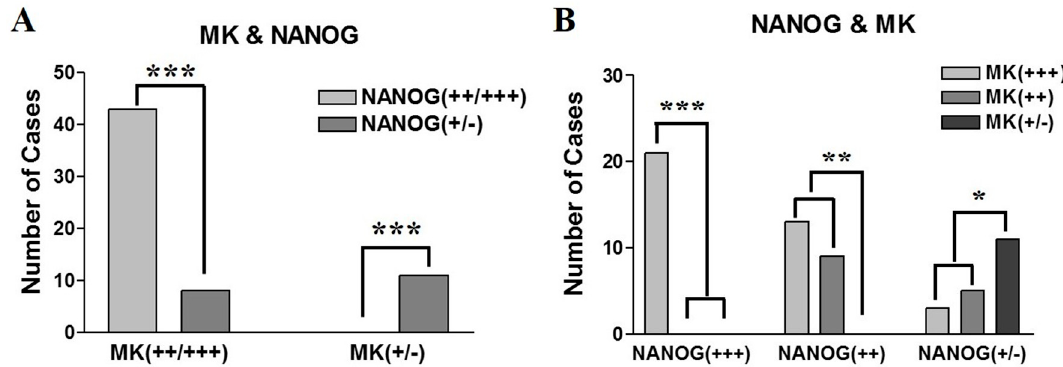
Figure 3. Graphs showing the correlation between IHC expression patterns of MK and NANOG in pretreatment OSCC specimens. ( A ) The enhanced expression (strong or moderate) of MK is significantly correlated with high expression of NANOG ( p < 0.001), whereas weak or negative expression of MK is positively associated with weak expression of NANOG ( p < 0.001); ( B ) similarly, strong or moderate expression of NANOG protein dominantly possess the enhanced MK protein ( p < 0.01), and weak expressions of NANOG and MK have a positive relationship ( p < 0.05). Data represent the number of cases with positive expression of each protein, and asterisks indicate statistical significances (* p < 0.05; ** p < 0.01; *** p < 0.001).